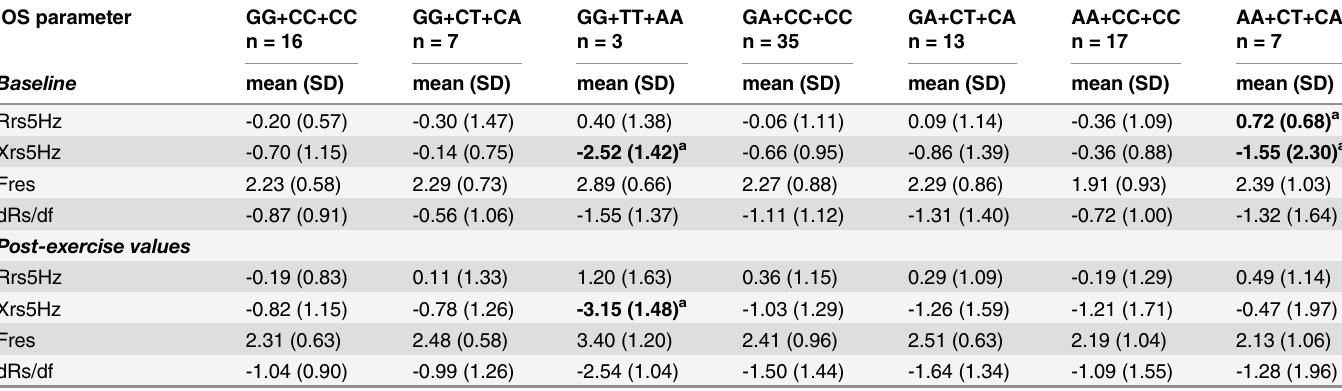
Table 6. Impulse oscillometry presented as Z-scores in relation to combined IL-10 rs1800896, rs1800871 and rs1800872 genotypes in 99 children under the age of seven after hospitalisation for bronchiolitis in infancy. IOS